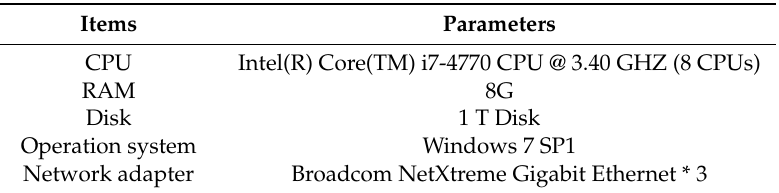
Table 5. Configuration of the test